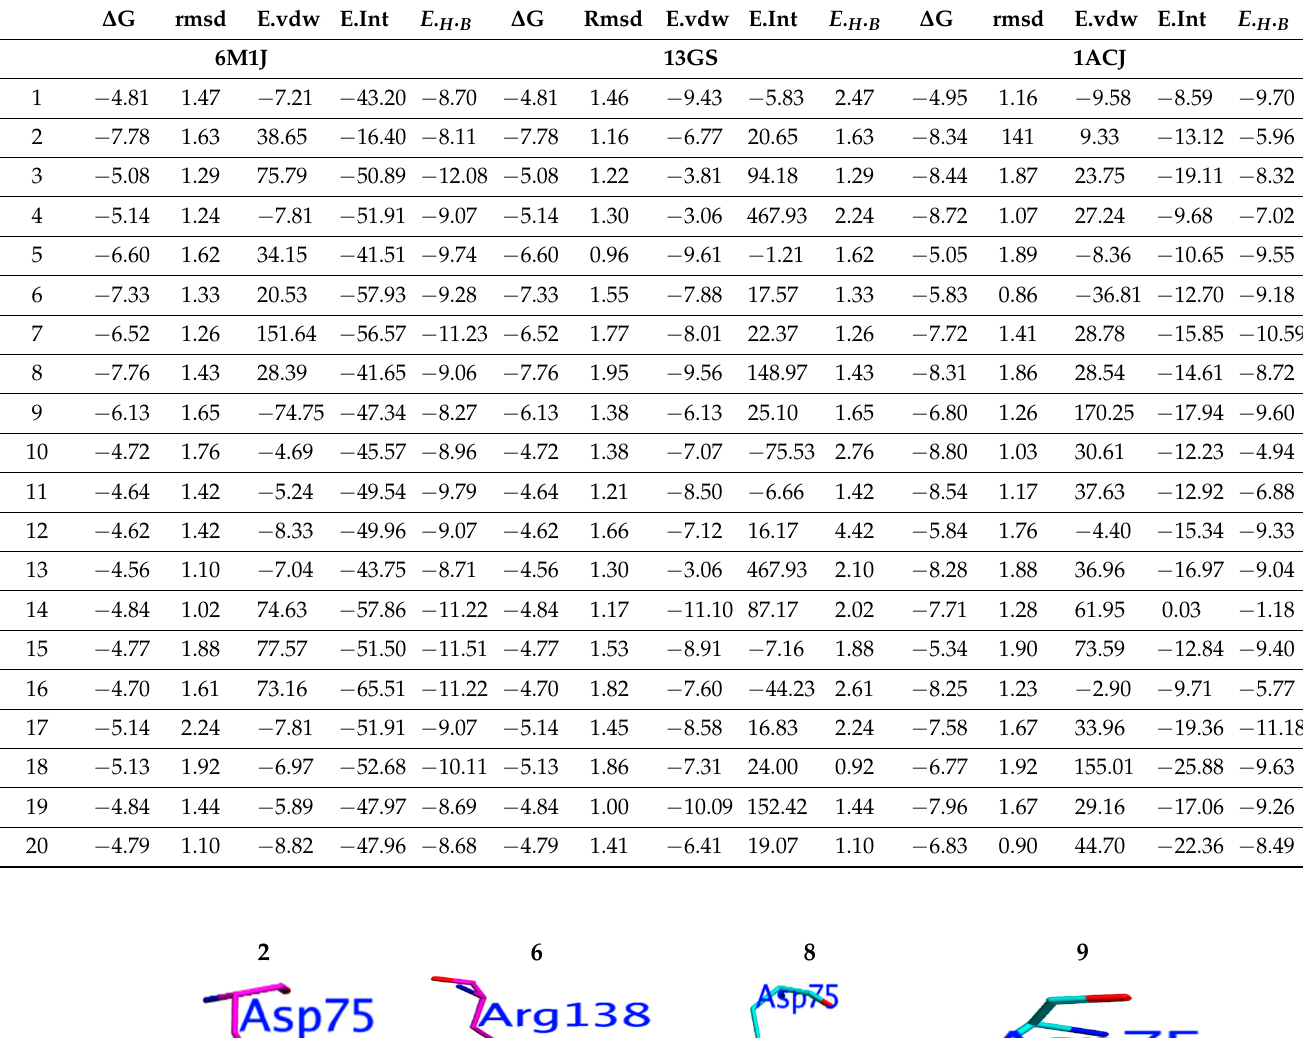
Table 6. The Docking energy scores (kcal/mol) for the identified molecules.